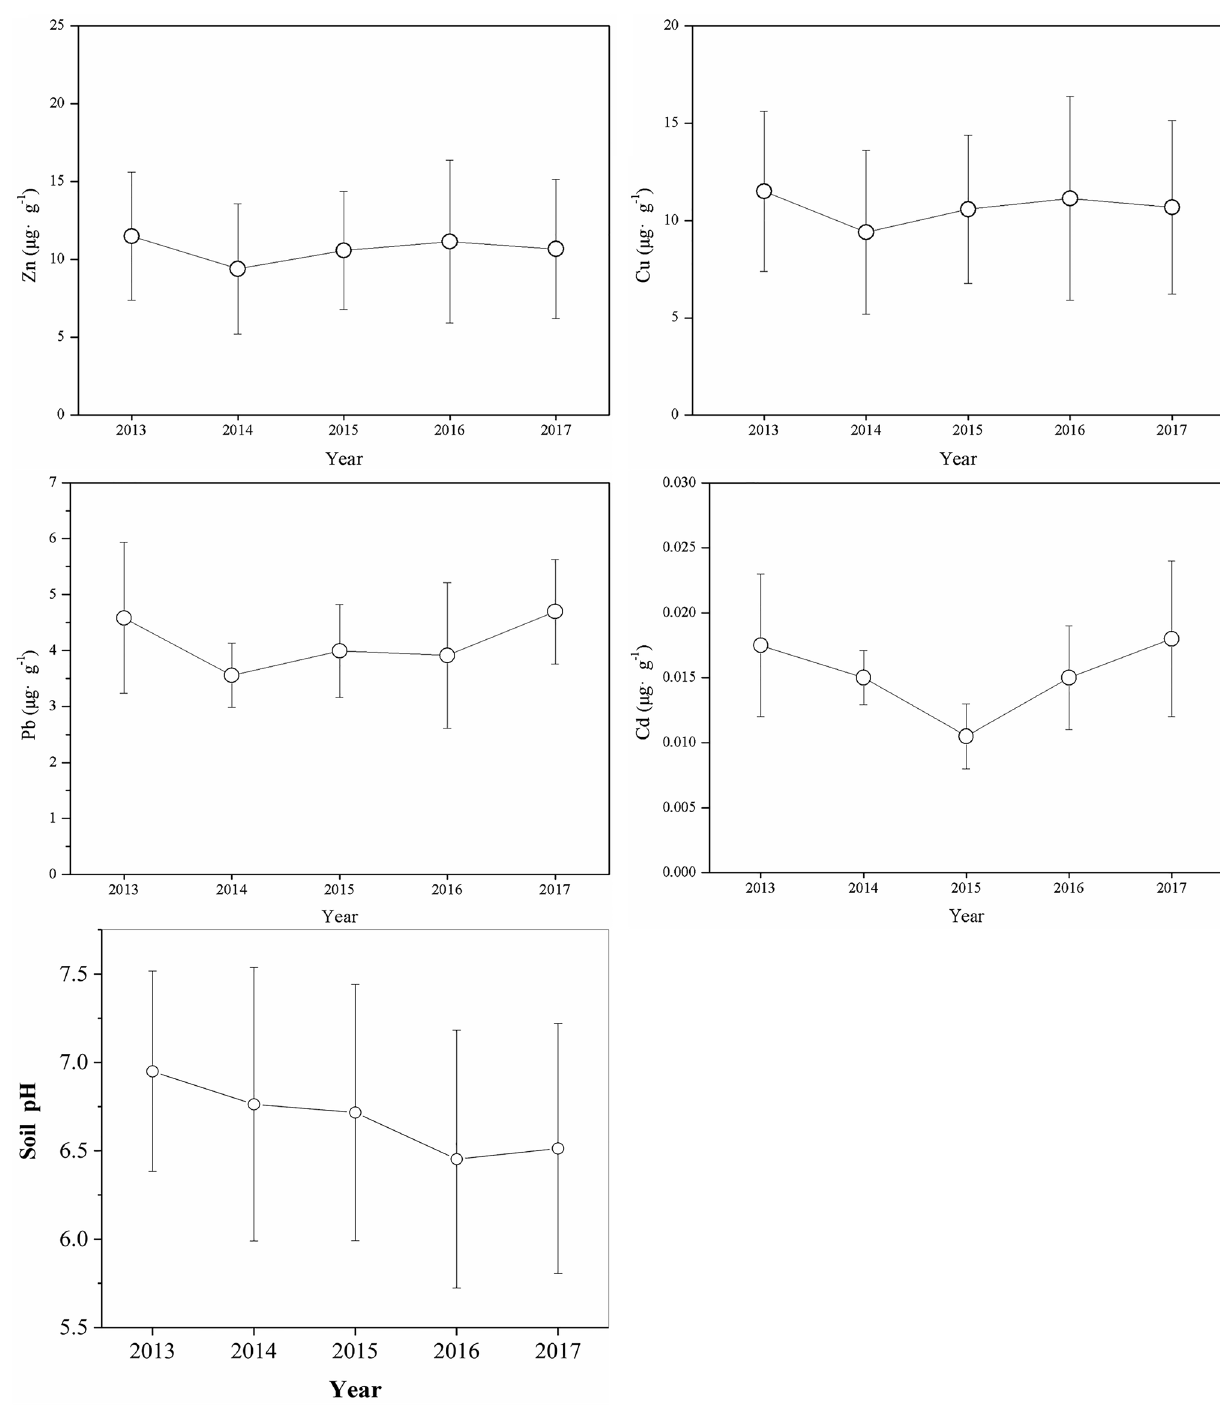
ard deviation during different years; the bars represent the stand- ard deviations of values from different stations in the study area